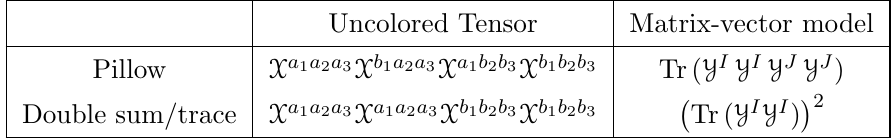
Table 3 . Quartic monomials that can be constructed from our tensor-valued